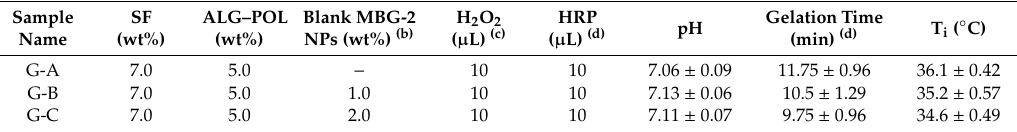
Table 3. Parameters for BG / alginate–poloxamer (ALG–POL) / silk fibroin (SF) hydrogels without factor loading (a) .